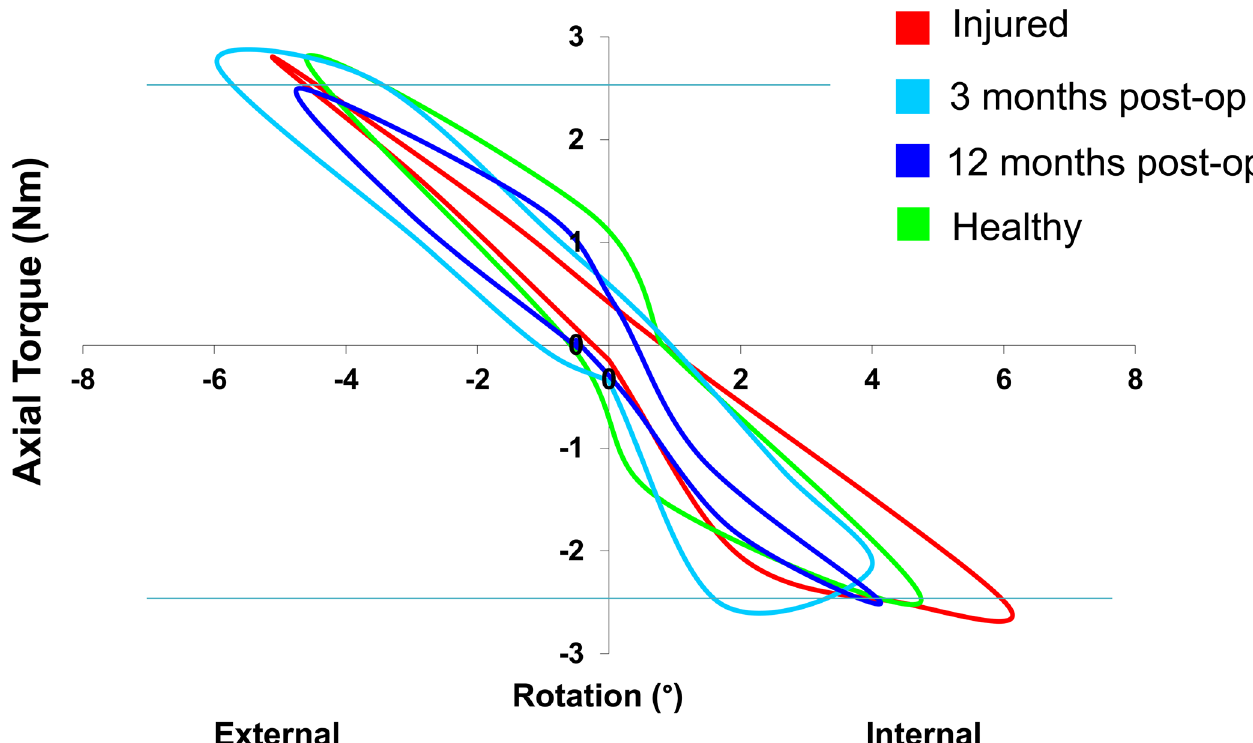
Fig 2. Example of the torque-rotational curves of one patient at the pre-operative (injured), 3 month postoperative and 12 month postoperative time points, as well as the healthy contralateral knee (healthy).